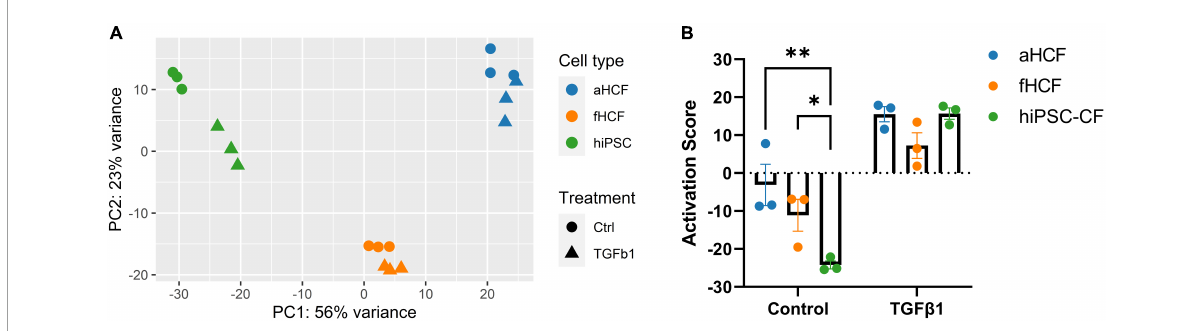
FIGURE2 Transcriptome dataset reveals distinct CF quiescence levels in control samples (A) Principal component analysis of normalized read counts for all samples. (B) Read counts for genes previously associated with CF activation were converted into z-scores. For each CF source, all z-scores were summed to yield the CF activation score. Two-way ANOVA followed by Tukey’s multiple comparisons test reveals significant differences in quiescent state for control samples, ∗ p -value < 0.05; ∗∗ p -value < 0.01. Panel (A) was created in Biorender (copyright agreement number: